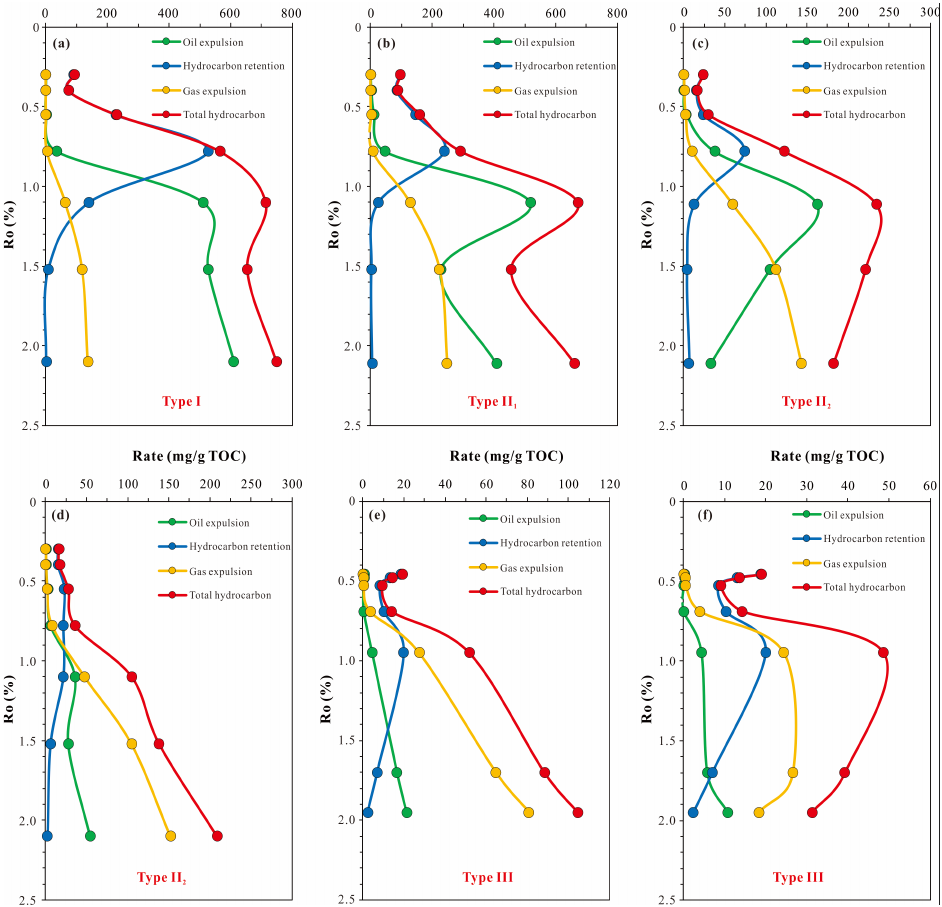
Figure 11. Variations in the hydrocarbon production rate with an increase in thermal maturity of the Es4 source rocks. ( a ) D16; ( b ) D22; ( c ) G25; ( d ) S499; ( e ) S101; ( f ) S101 (Parallel experiment).